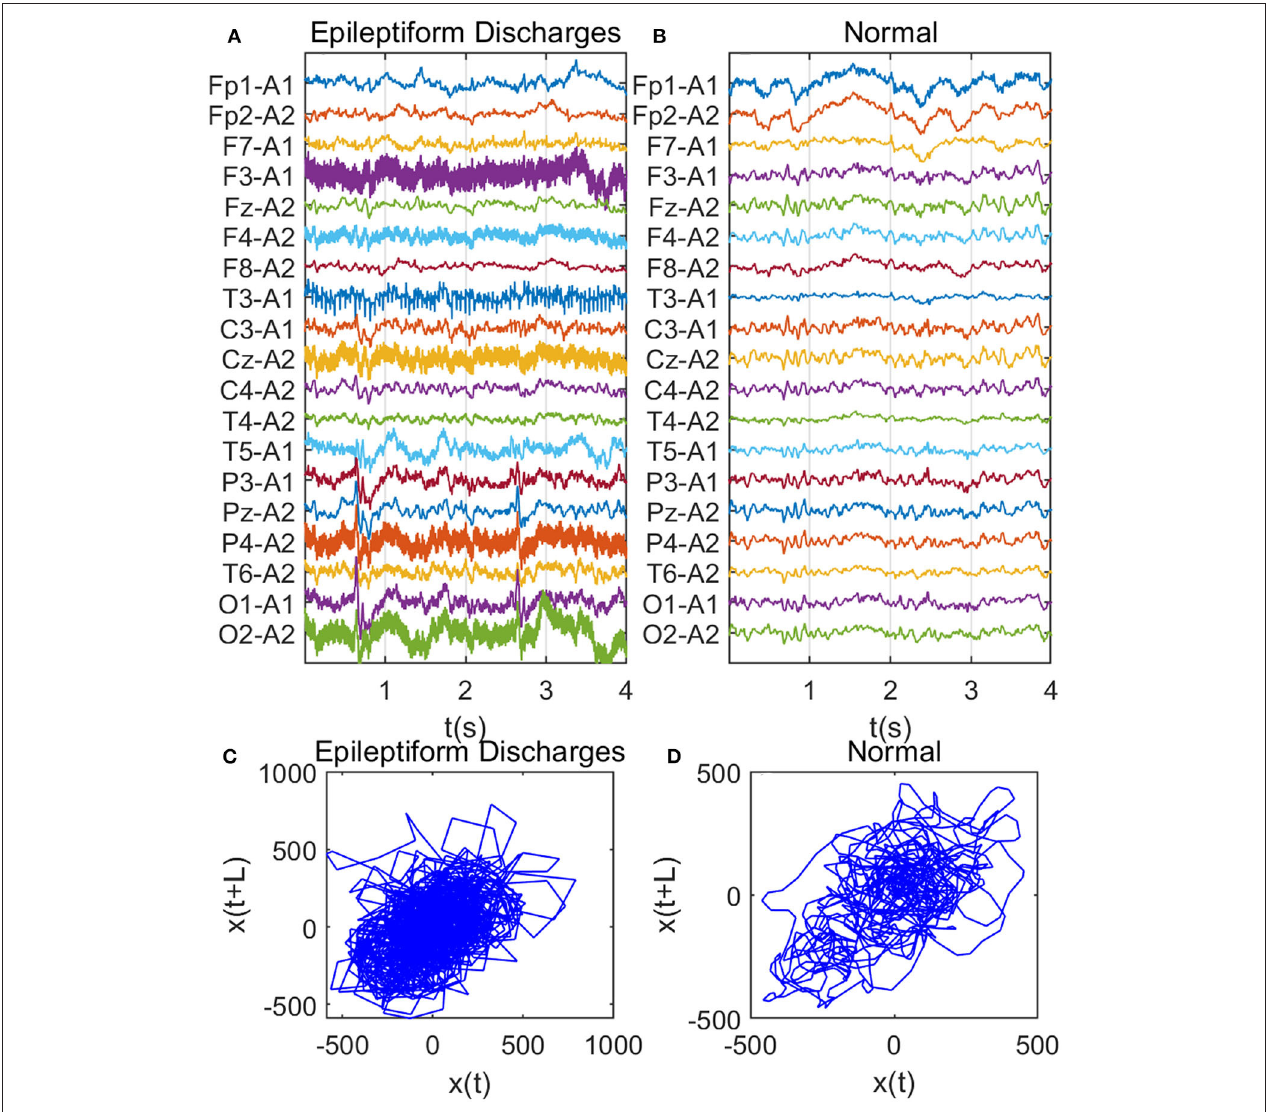
FIGURE 3 | Comparison of epileptiform discharges and normal EEG: (A) example of epileptic discharges, (B) normal EEG, (C,D) 2-D phase diagrams using the summation of the 19 epileptiform discharges and normal EEG signals shown in (A,B) , respectively, which can be used to estimate Signal Range.